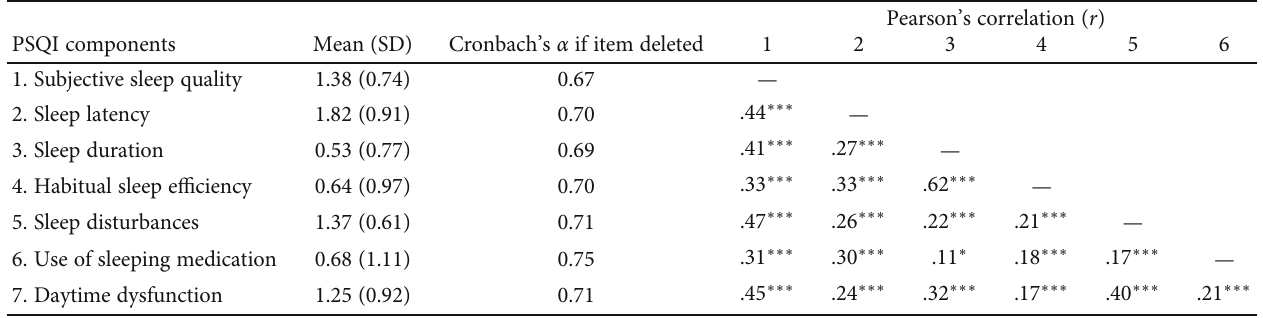
Table 1: Descriptive statistics and internal consistency (Cronbach ’ s α ) of the PSQI components and correlations among them.